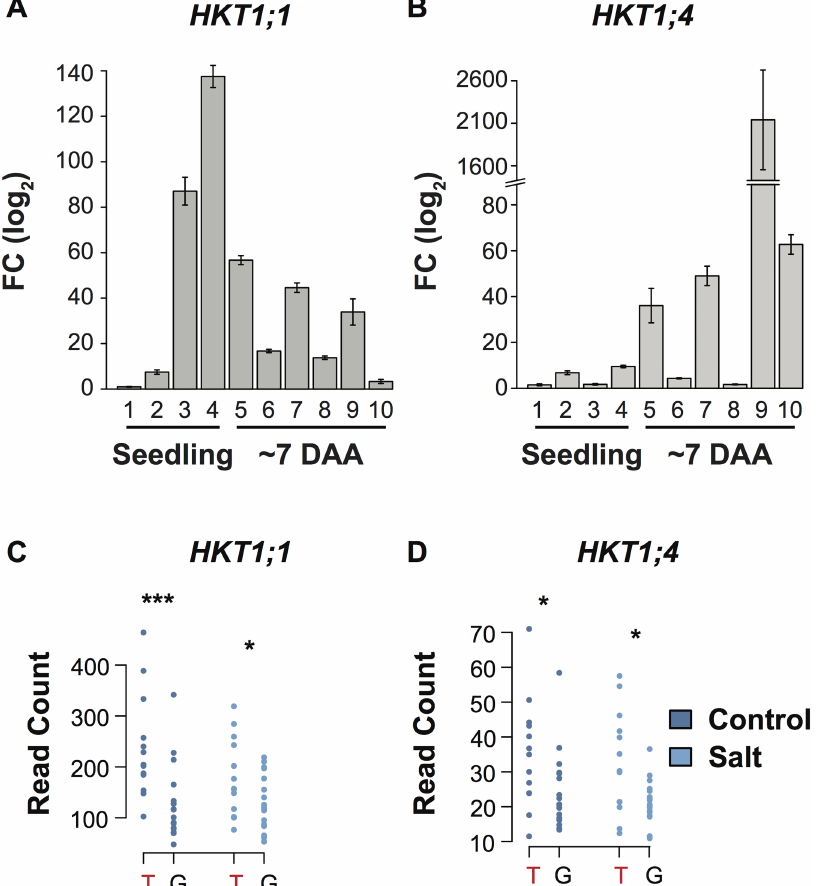
Fig 4. Characterization of HKT1;1 and HKT1;4 expression. Expression profiles of HKT1;1 (A) and HKT1;4 (B) in seedingand mature plants. Numbers below each of the bars indicate different tissues as follows: 1: seedlingroot, 2: seedlingshoot, 3: blade of newest fully expanded leaf in seedling(leaf 3), 4: sheath of newest fully expandedleaf in seedling(leaf 3), 5: penultimate leaf sheath in mature plant, 6: penultimate leaf blade in mature plant, 7: flag leaf sheath in mature plant, 8: flag leaf blade in mature plant, 9: culm of mature plant and 10: panicleof mature plant. DAA: days after anthesis. (C, D) Dot plots comparingthe expressionof HKT1;1 (C) and HKT1;4 (D) betweenallelicgroups at SNP-4-30535352 in control and saline conditions. The minor allelegenotype, which displayshigherroot Na + content, is indicatedby red text. A Mann-Whitney test was performed within each treatment to determinedifferences betweenthe two groupswith asterisks indicating significanceas determinedusing a one-wayANOVA: *** : p < 0.001; * : p < 0.05.